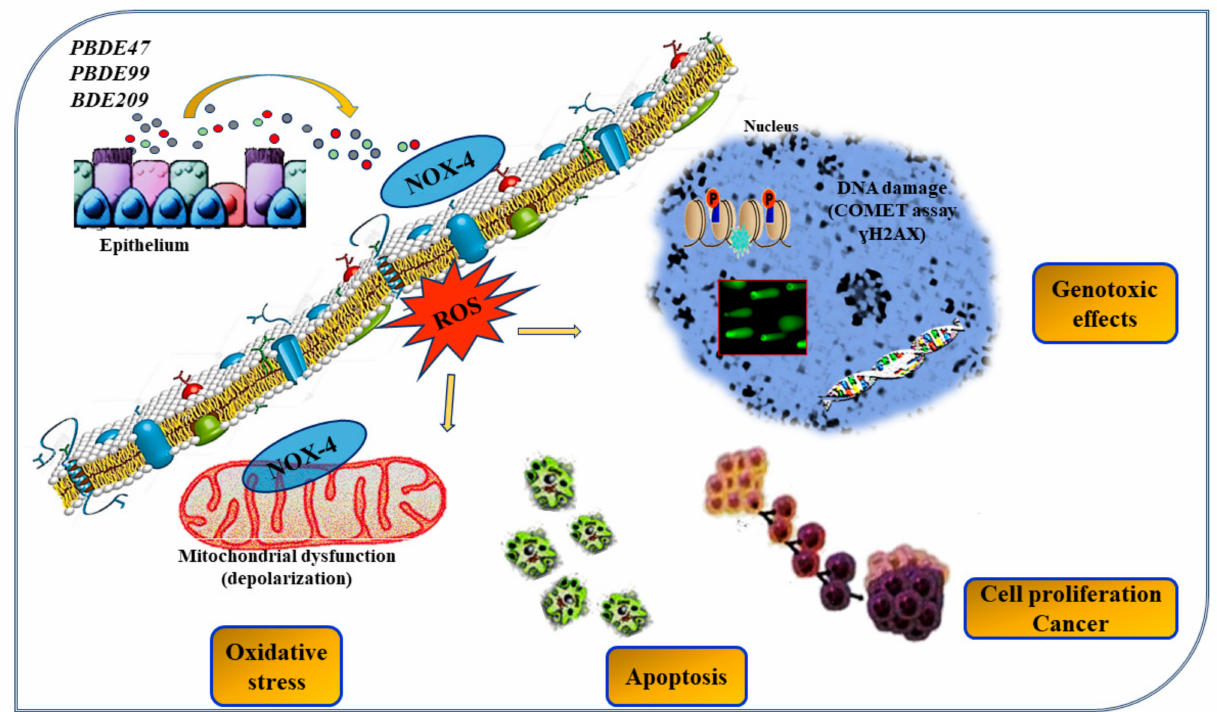
Figure 1. Effects of PBDE-47, -99, and -209 flame retardants in bronchial epithelial cells. PBDE-47, -99, and -209 cause DNA damage of epithelial cells and alter the activity of histone protein γ -H2AX in in vitro/ex vivo cell models of human bronchial epithelial